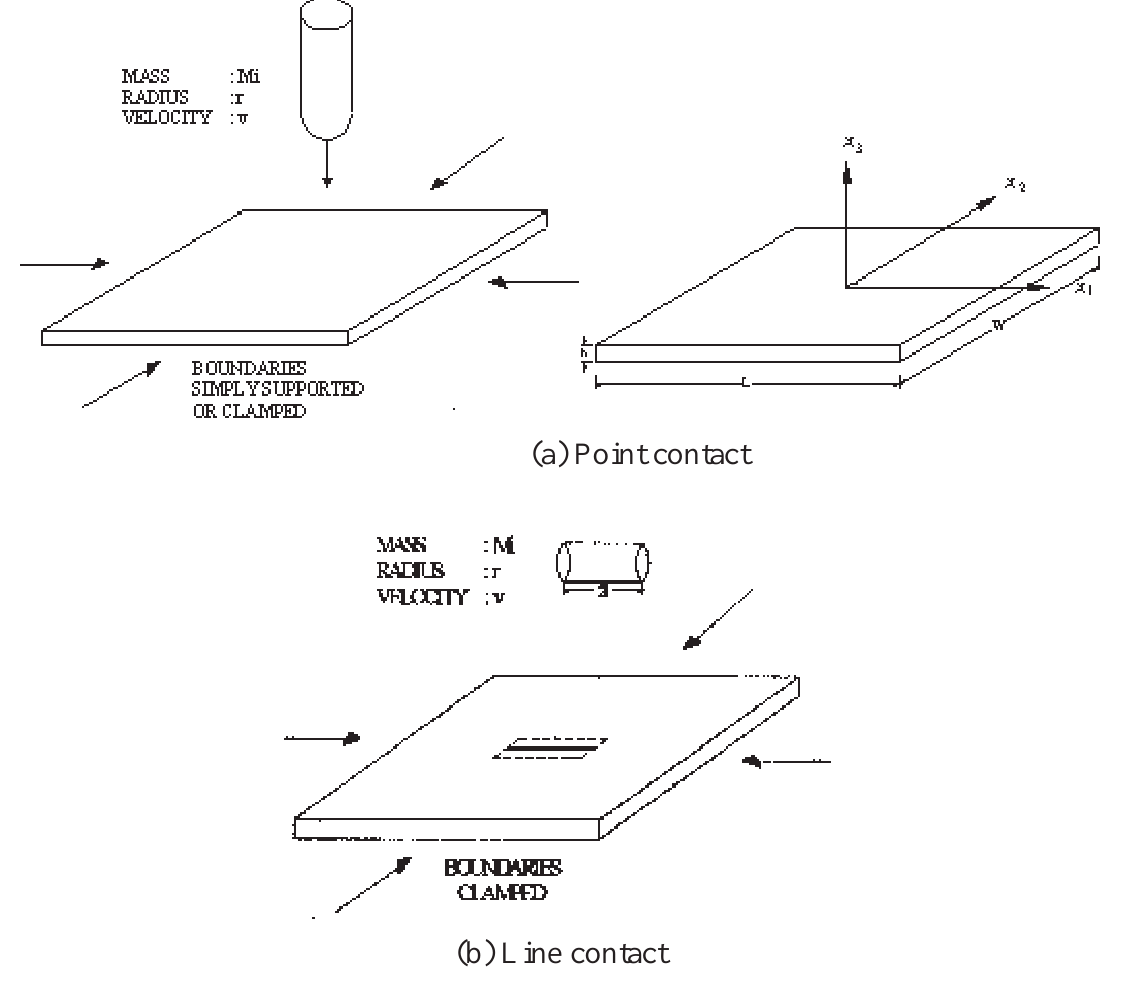
Fig. 1. Description of the problem and co-ordinate